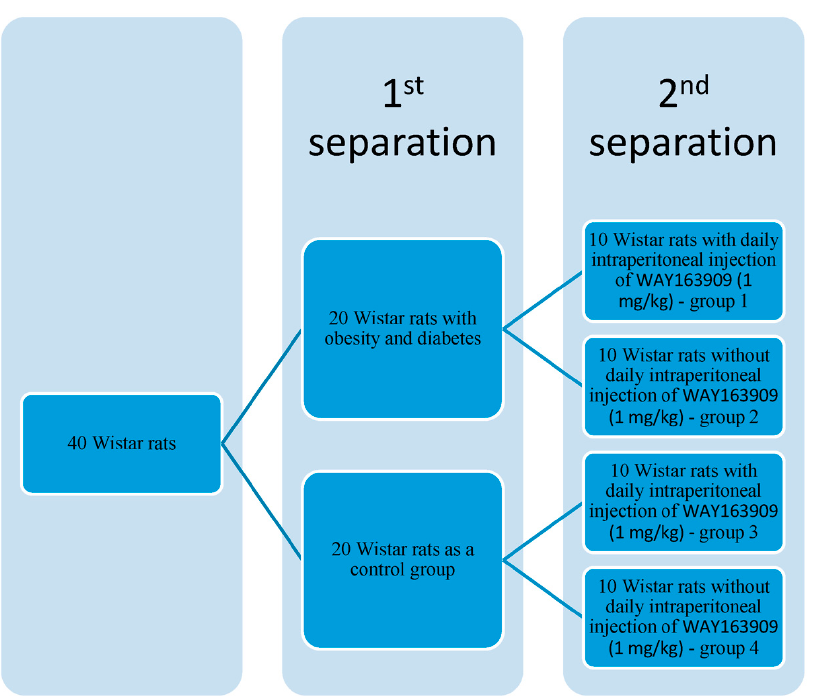
and gently massaging the tail from the base upwards to generate a blood droplet. This droplet was captured on a glucose strip placed inside a handheld glucometer (FreeStyle Optium Neo, Abbott Diabetes Care Ltd., Maidenhead, Berkshir, UK), which normally requires 0.5–2 µ L of blood, and the result was obtained after 3 s on the glucometer screen in